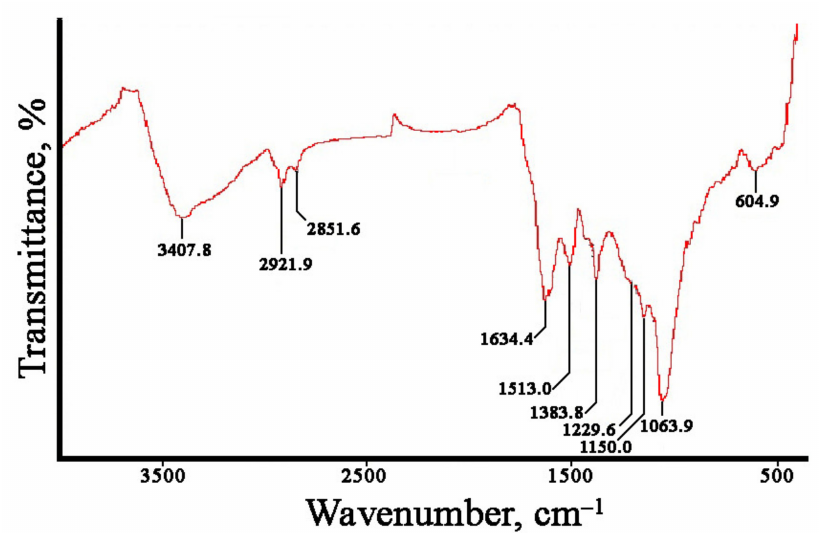
Figure 9. Fourier-transformed infrared (FTIR) spectroscopy analysis of bimetallic Ag/Au (1:1) NPs synthesized with L . erythrorhizon callus